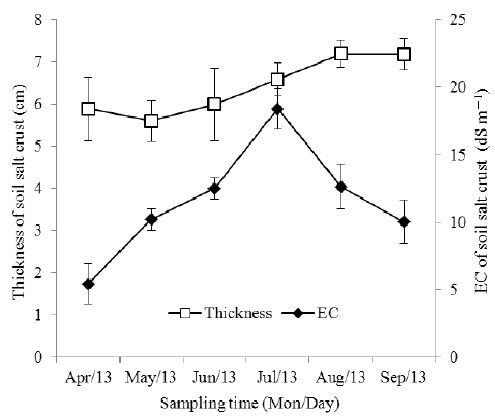
Figure 6. Monthly variations in soil salt crust thickness and EC during the growing season in the Taklimakan Desert Highway Shelterbelt irrigated with 4.04 g·L − 1 groundwater. Error bars show 1 standard deviation.